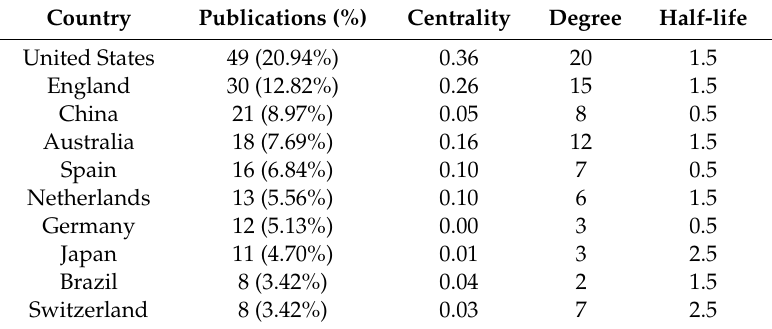
Table 5. Publication rate depending on the country.